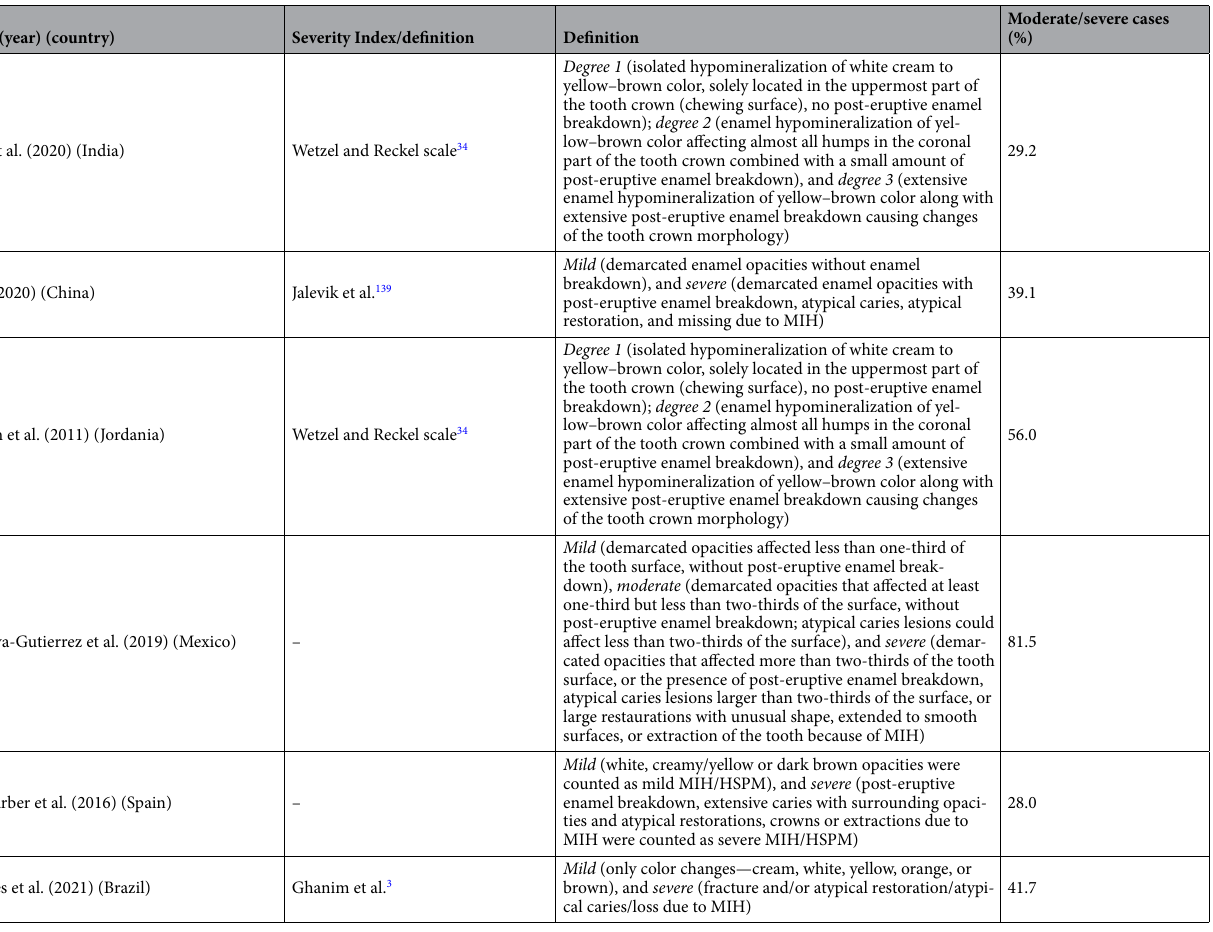
Table 3. Detailed case definition of MIH severity for each study with the respective reported prevalence. NR Not reported, NI No information, EAPD European Academy of Pediatric Dentistry 1 , mDDE modified Developmental Defects of Enamel index.